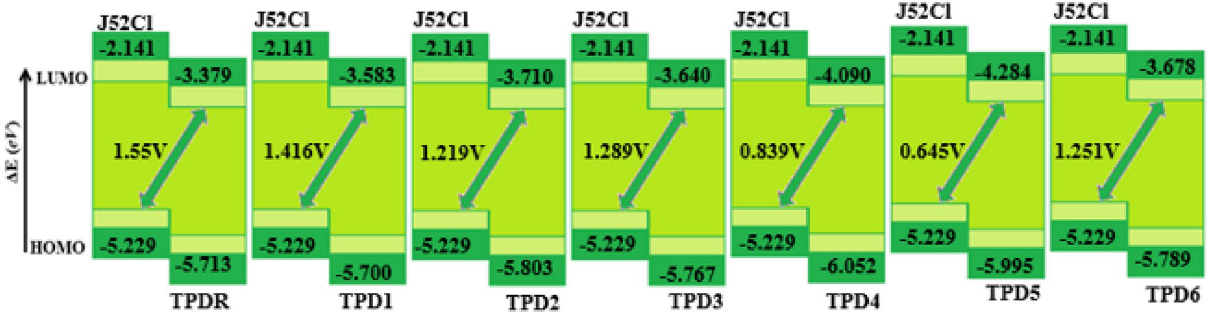
Figure 7. Graphical representation of Voc for entitled chromophores with J52Cl . All out put files of entitled compounds were accomplished by Gaussian 09 version D.01 (https:// gauss ian. com/ g09ci